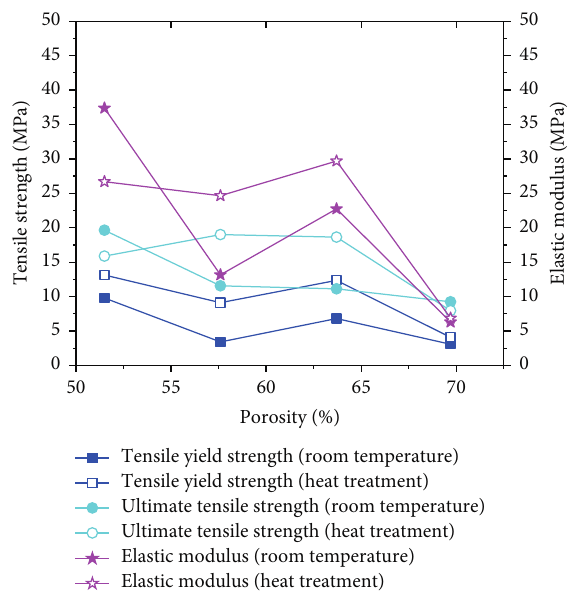
Figure 16: Effect of heat treatment on the tensile strength and the elastic